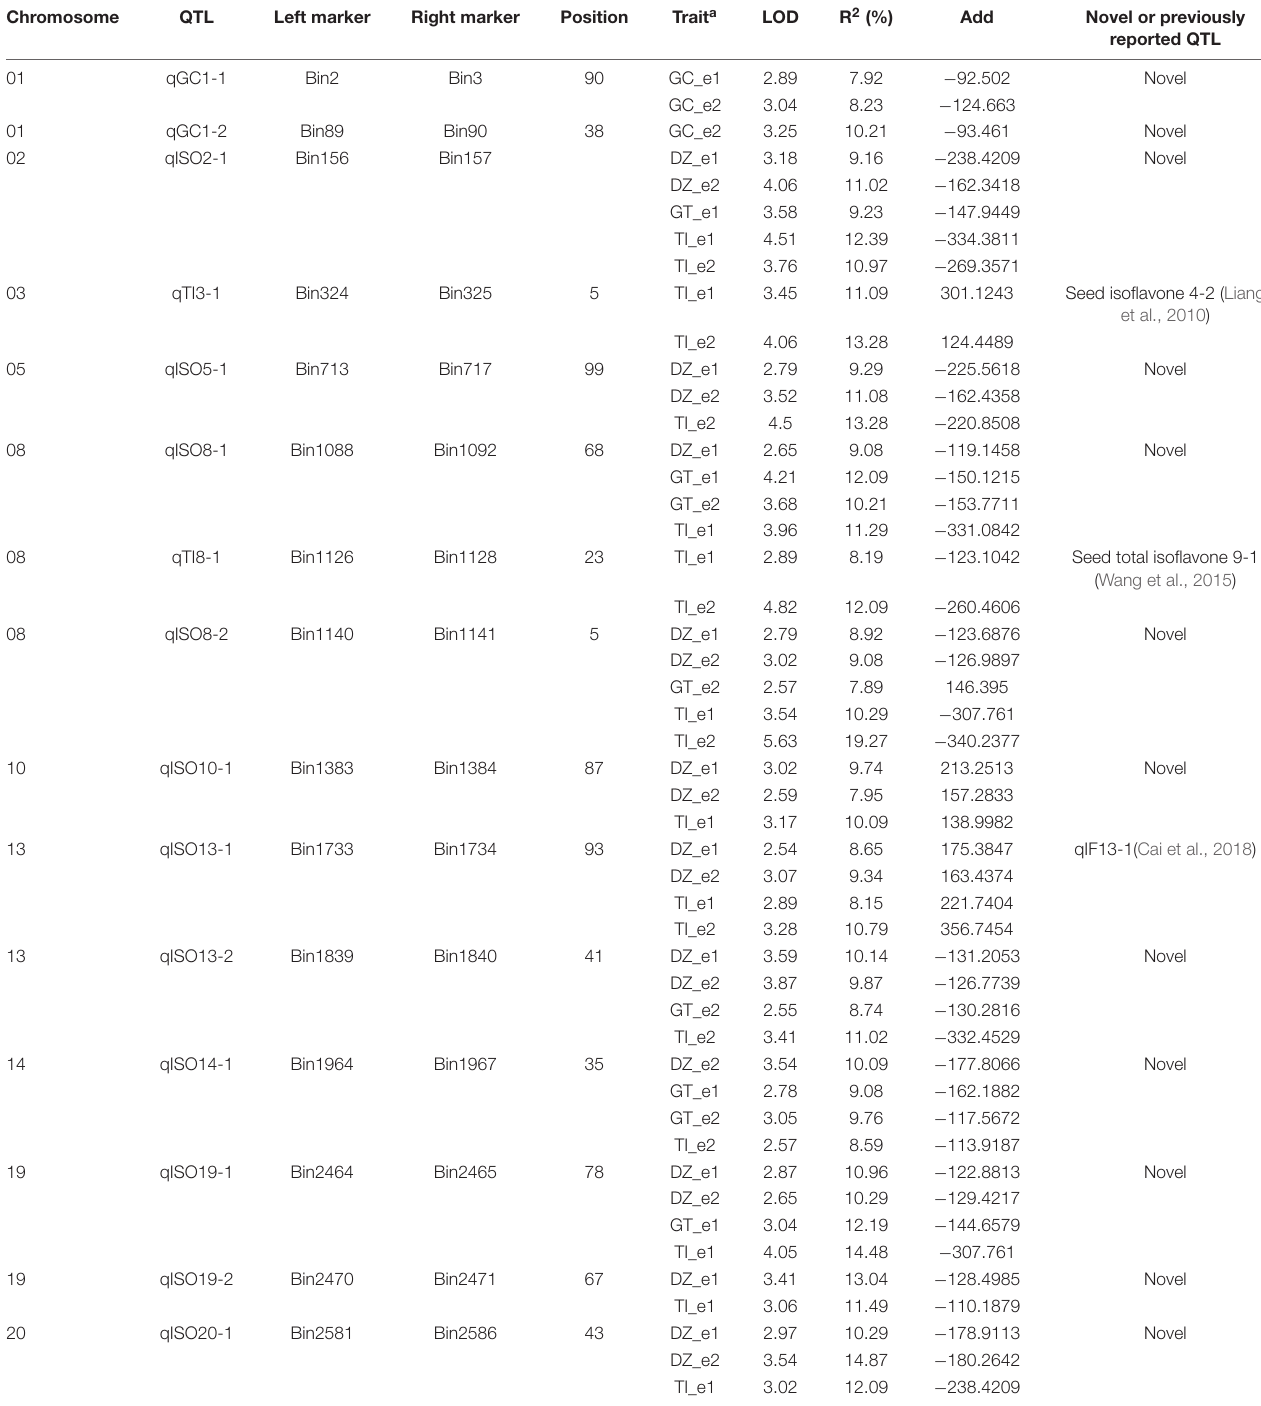
TABLE 1 | Quantitative trait locis underlying soybean isoflavone content in two environments. Chromosome QTL Left marker Right marker Position Trait a LOD R 2 (%) Add Novel or previously